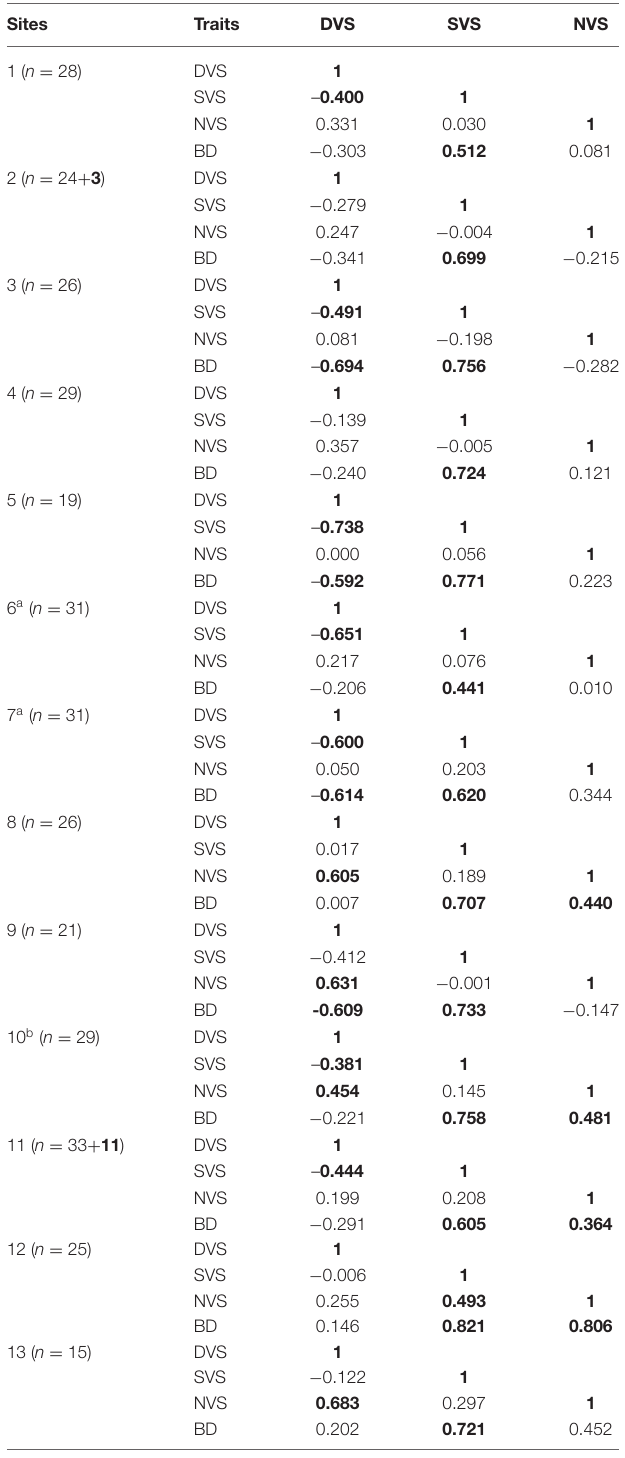
TABLE 5 | Pearson correlation coefficients between anatomical traits and BD at the intrapopulation level for all the studied populations. Sites